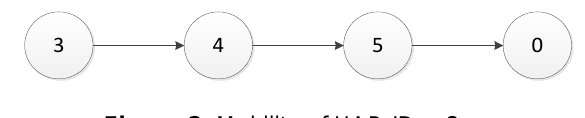
Figure 2 . Mobility of UAP ID =